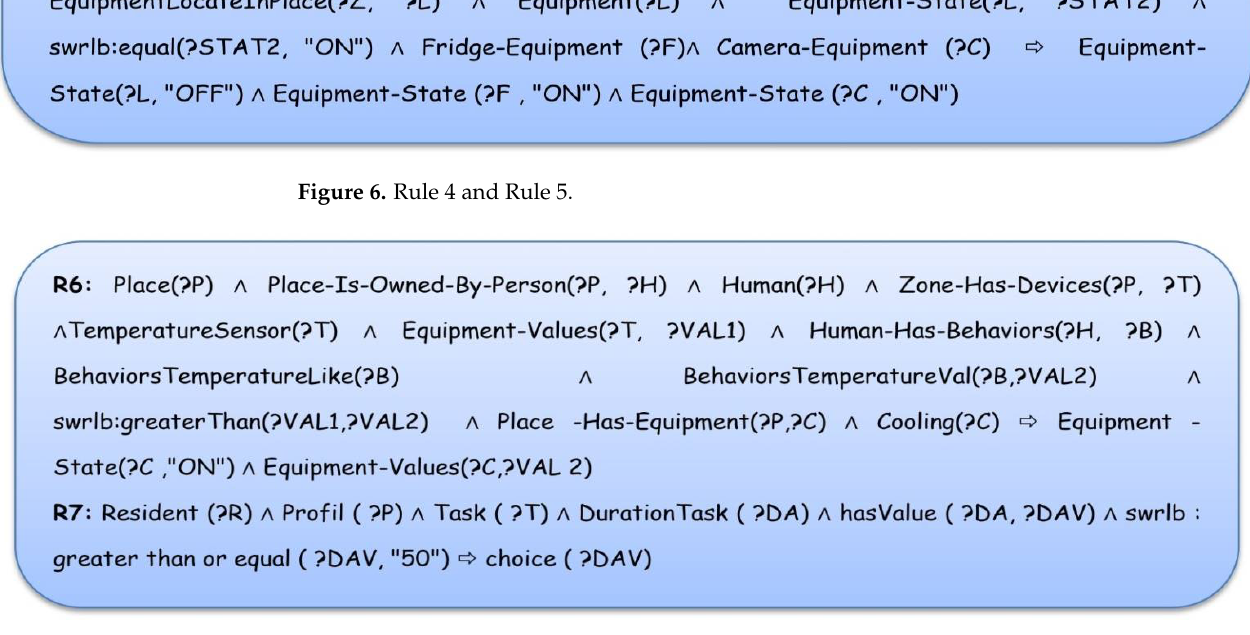
Figure 7. Rule 6 and Rule 7.